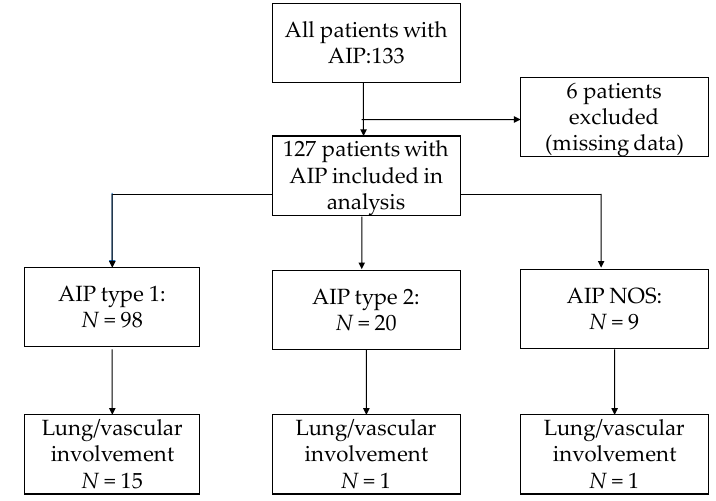
Figure 1. Flow chart of the included patients. Table 1. Demographic and clinical characteristics of patients.